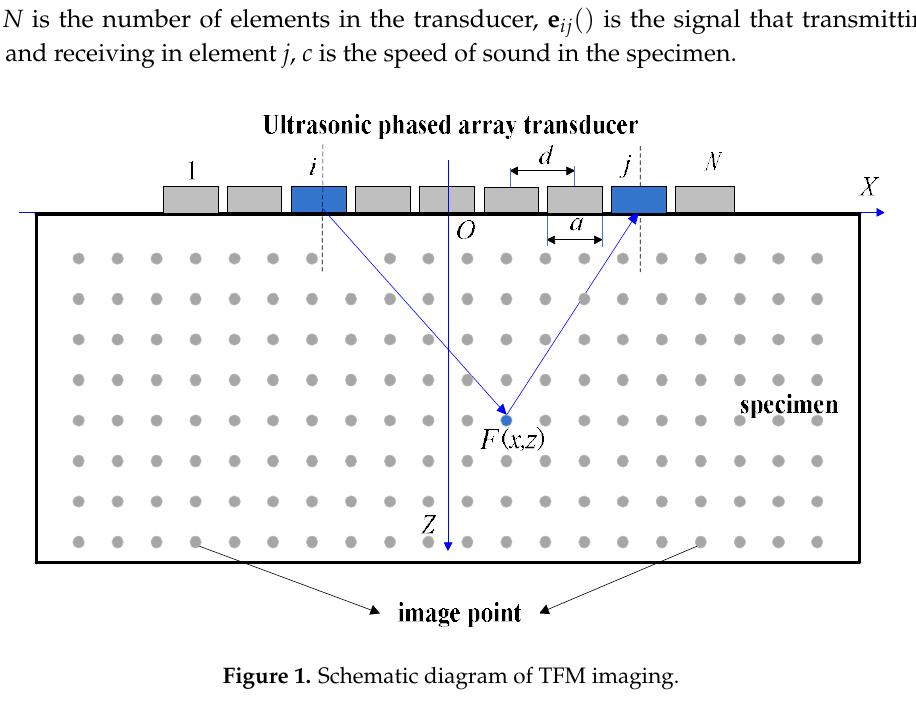
Figure 1. Schematic diagram of TFM imaging.